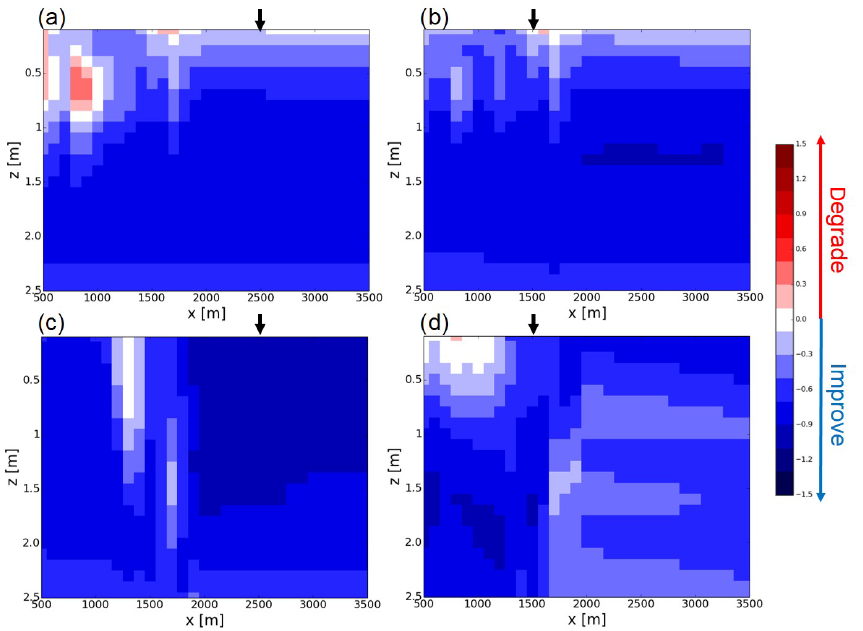
Figure 2. The improvement rates of the (a) LOW_K-UP_O, (b) LOW_K-DOWN_O, (c) HIGH_K_UP_O, and (d) HIGH_K-DOWN_O experiments (see Table 1 and Sect. 3). Black arrows show the locations of the soil moisture observations in each